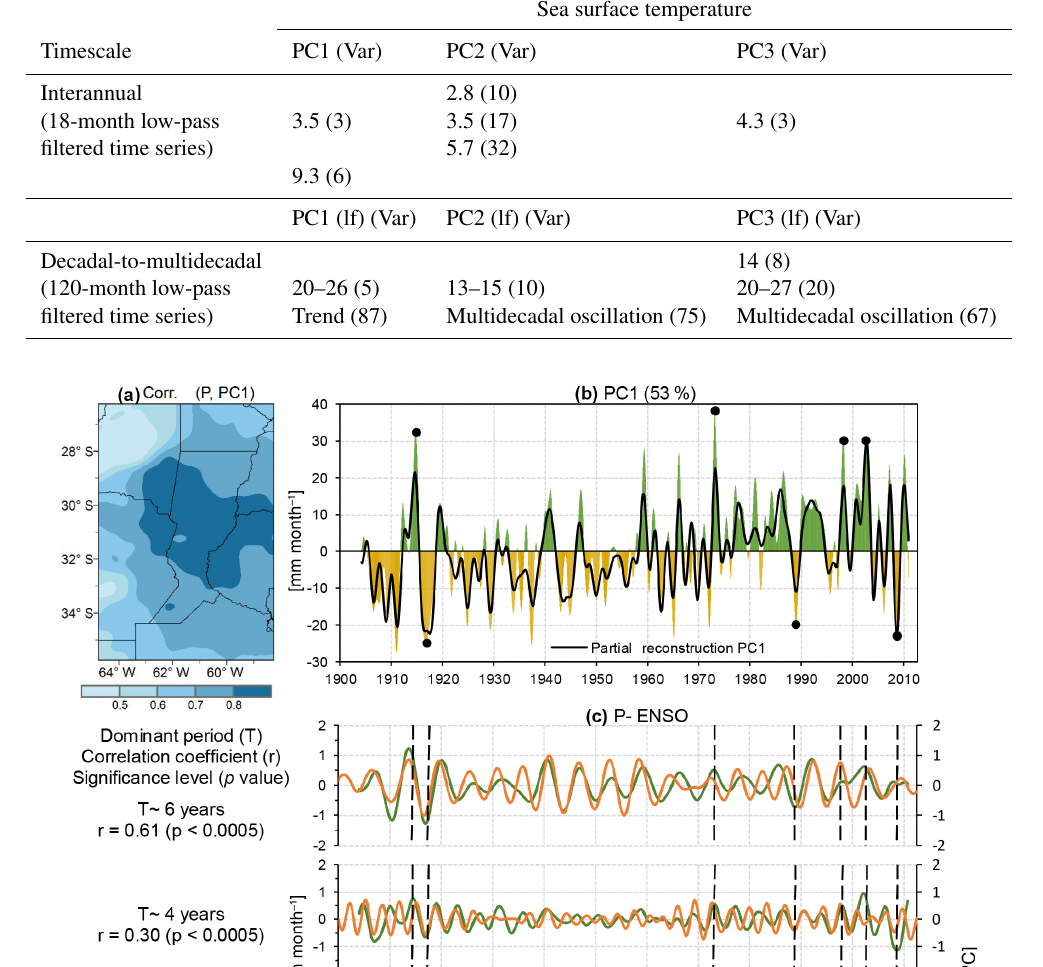
Table 1. Trends and dominant periodicities obtained from applying SSA to the first three PCs and PCs (lf) of the 18- and 120-month low-pass- filtered SST global patterns, respectively. The analysis is performed on interannual timescales (between 2 and 10 years) and lower frequency or decadal-to-multidecadal timescales (higher than 10 years). The percentage of variance explained by each mode is given in brackets.